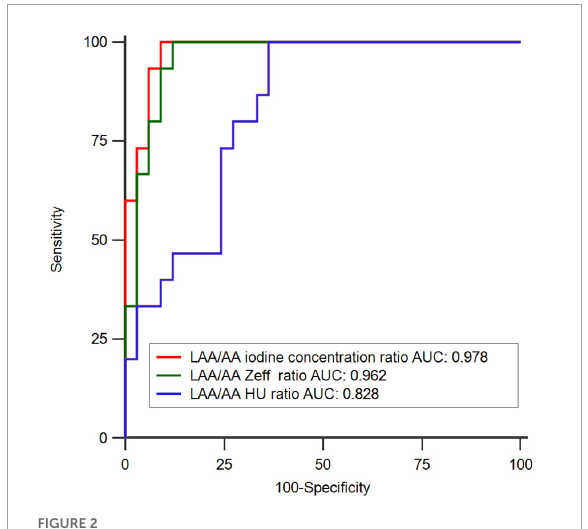
FIGURE2 Receiver operating-characteristic curve (ROC) analysis in differentiating thrombus from circulatory stasis using transesophageal echocardiography (TEE) as the reference standard. The areas under the ROC (AUC) of LAA/AA iodine concentration ratio (0.978; 0.945–1.000) and LAA/AA Z eff ratio (0.962; 0.913–1.000) showed significantly larger than that of LAA/AA HU ratio (0.828; 0.714–0.942) ( P < 0.05).